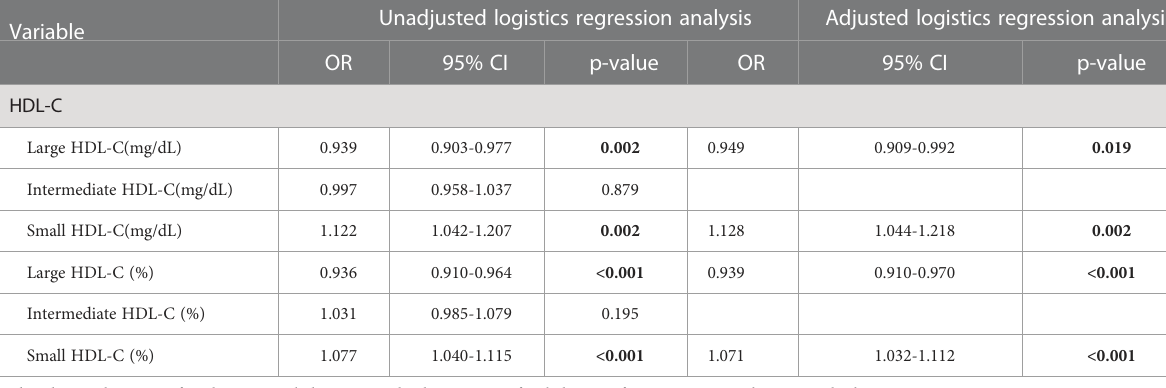
TABLE 2 Associations of HDL subfractions with T2DM and SCAD by logistic regression